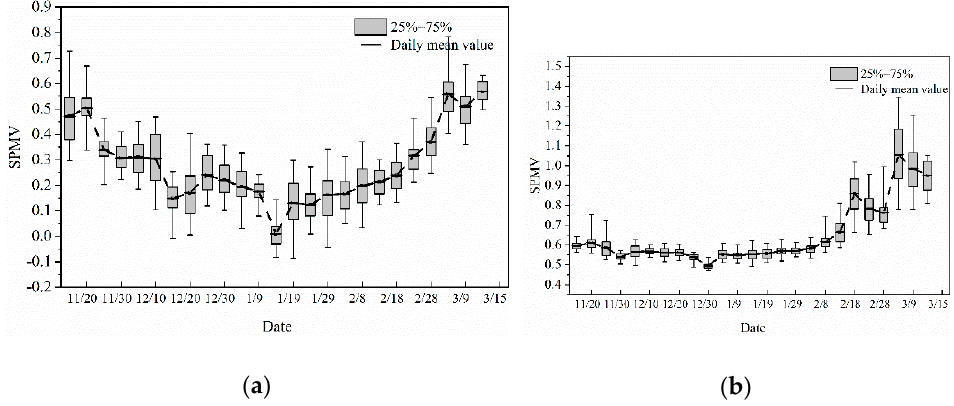
Figure 5. SPMV for north-facing bedroom heating season: ( a ) original building and ( b ) standard building.